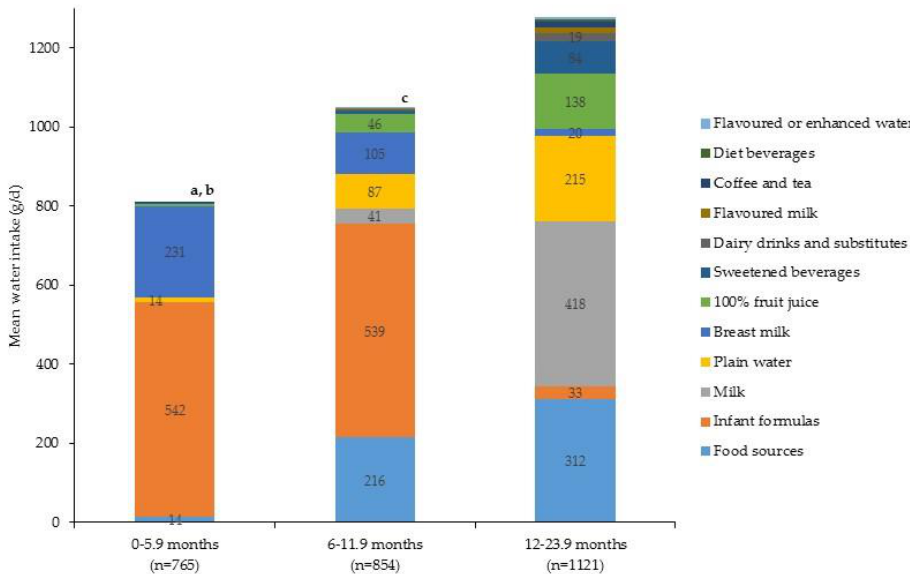
Figure 5. Per capita daily intake of water (g/day) from beverage and food sources by age group ( n = 2740) 1 . 1 Wald F -test to assess overall group difference in daily mean intake (g/day) of water p < 0.001; Independent T -test with Bonferroni adjustment for multiple comparisons was used to assess differences between each sub-group. Sub-group differences indicated by: a 0–5.9 months vs. 6.0–11.9 months p < 0.05; b 0–5.9 months vs. 12.0–23.9 months p < 0.05; c 6.0–11.9 months vs. 12.0–23.9 months p <